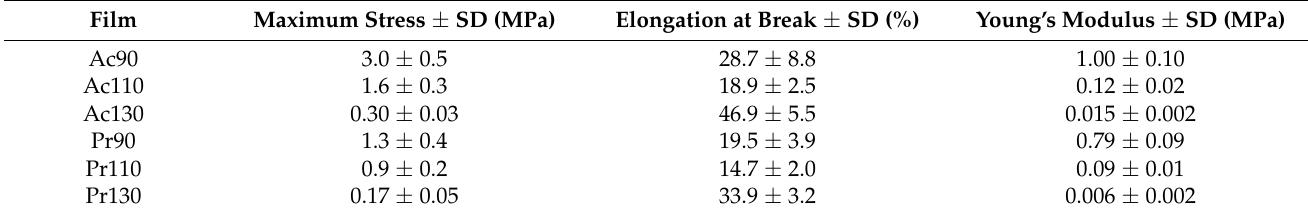
Figure 8. Typical tensile stress–strain curves of IL based cellulose films. ( a ) Ac90, ( b ) Ac110, ( c ) Ac130, ( d ) Pr90, ( e ) Pr110, ( f ) Pr130. Table 6. Tensile-strength values calculated by a mean of five valid assays. Error associated to the presented values is the standard deviation (SD) of the five valid